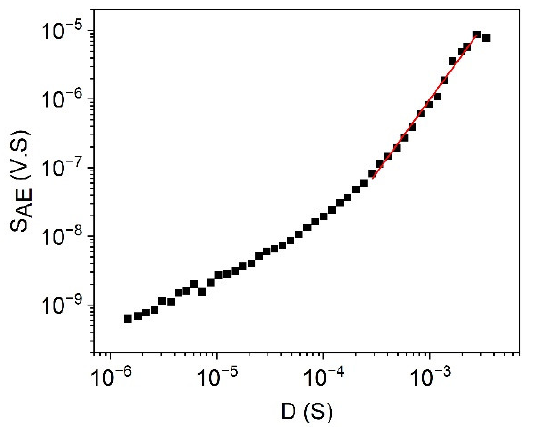
Figure 11. logS AE versus logD plot for heating in alloy B (at B = 0). The slope is sensitive to the Figure 11.   versus  plot for heating in alloy B (at B = 0). The slope is sensitive to the window of fit: e.g., fitting between 0.2 mS and 3 mS, the slope is 2.14 ± window of fit: e.g., fitting between 0.2 mS and 3 mS , the slope is 2.14 ± 0 .17.